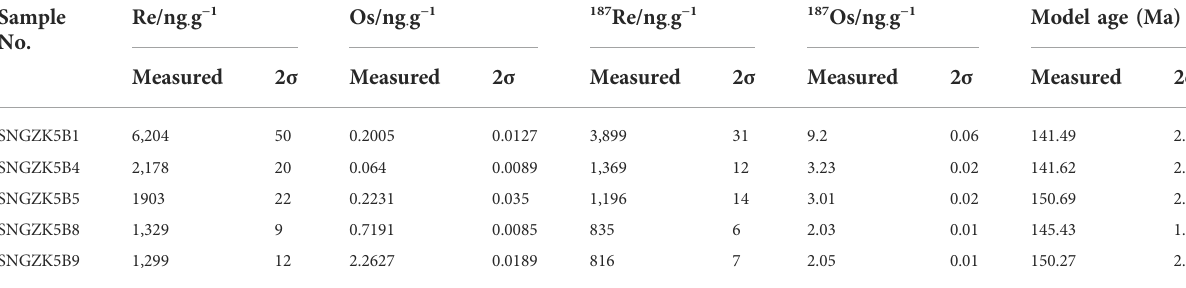
TABLE 3 Re – Os isotopic data for molybdenum from the Shanagen hydrothermal vein-type Mo deposit. Sample